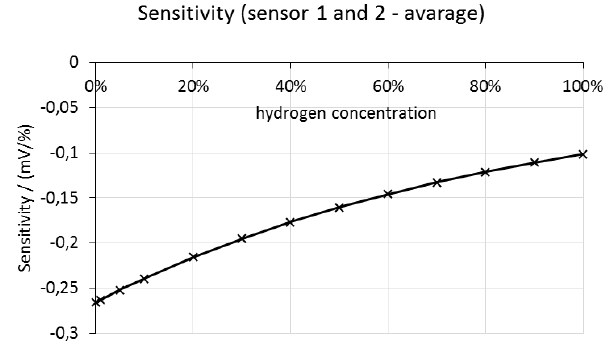
Figure 7. Measurements of the sensor 1 signal with different low H 2 concentrations. The measurements were performed at 5 ◦ C in a climate-controlled room. The lower detection limit of 4% hydrogen can easily be distinguished by a sensor output voltage drop of 4.8% as compared to the output voltage in the air.